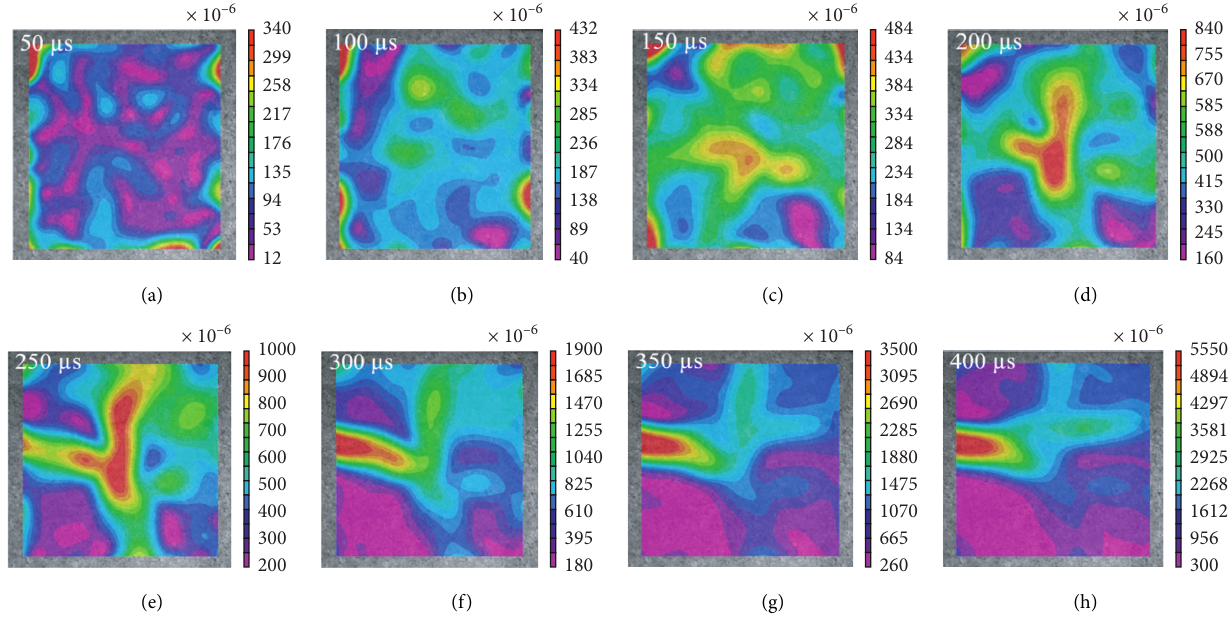
Figure 4: The evolution of von Mises strain for test 1. (a) 50 μ s. (b) 100 μ s. (c) 150 μ s. (d) 200 μ s. (e) 250 μ s. (f) 300 μ s. (g) 350 μ s. (h) 400 μ